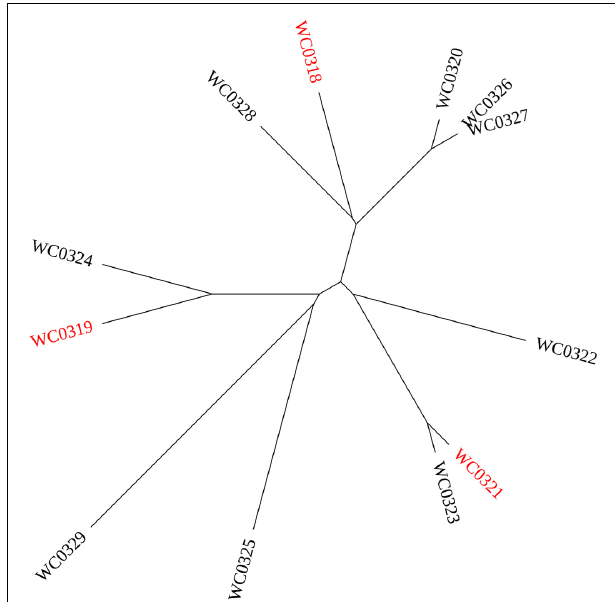
FIGURE 5 | UPGMA cladogram of the 12 strains Leuconostoc carnosum according to their phenotypic traits. The strains selected for the mice colonization study are labeled in